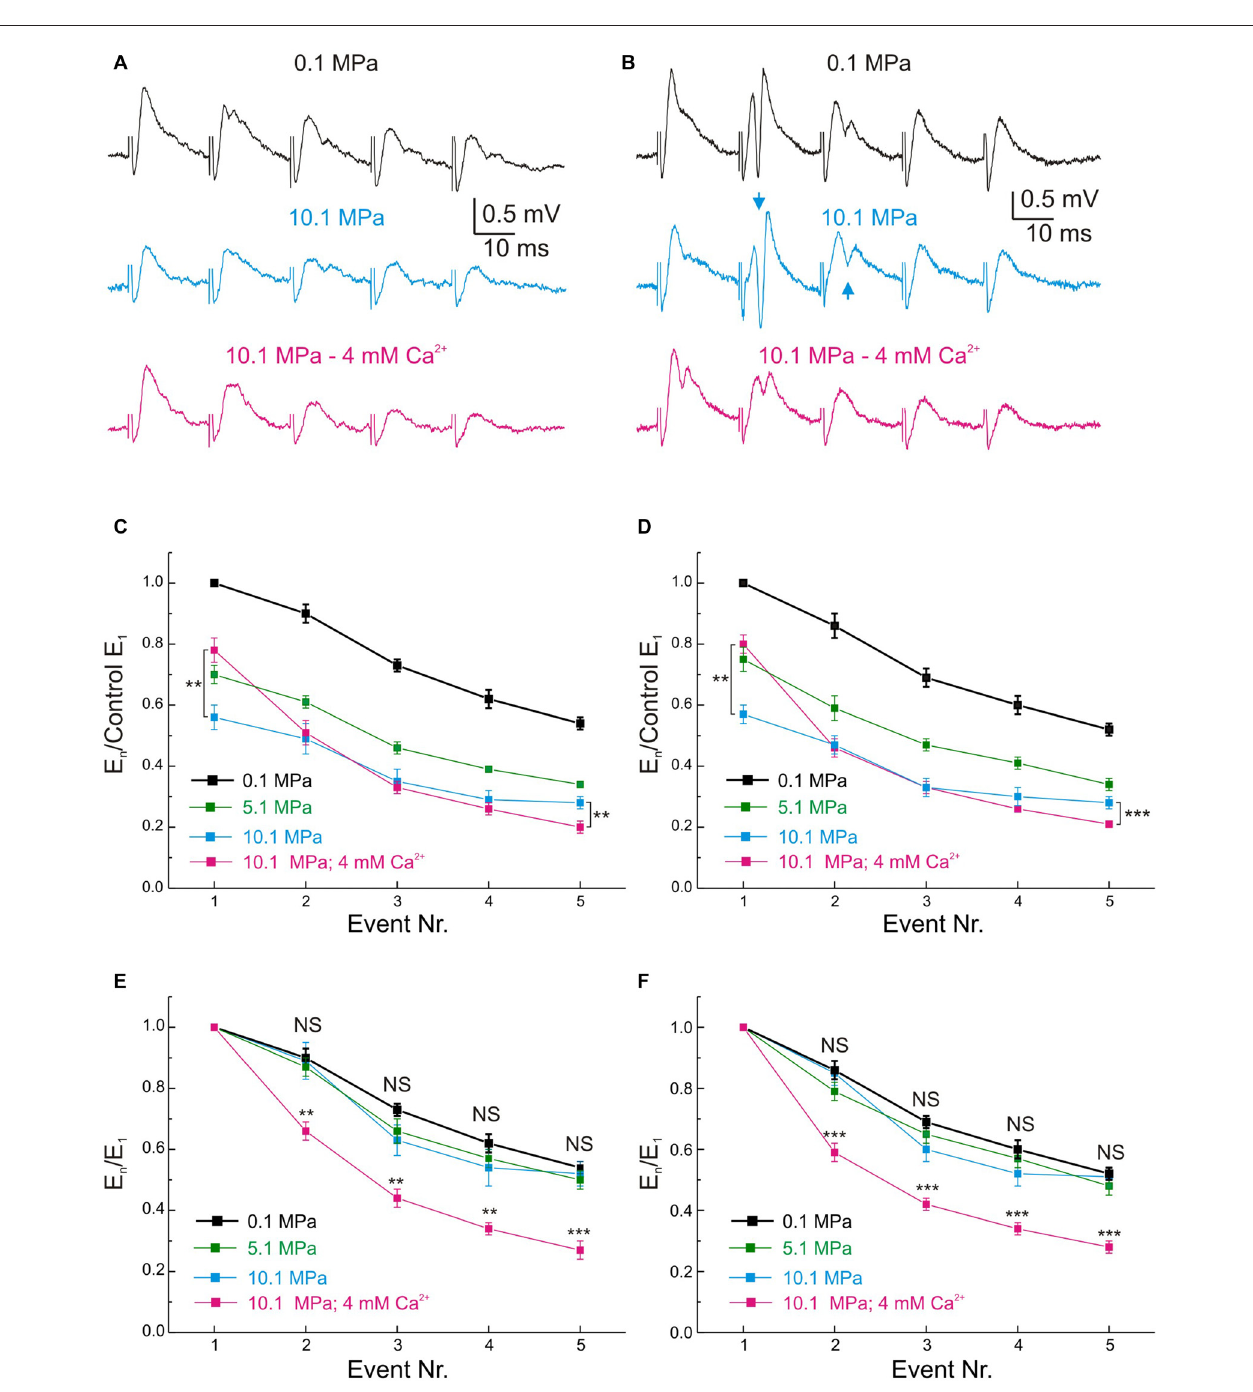
FIGURE 5 | Effects of pressure and [Ca 2 + ] o on the MPP fEPSP during stimulation at 50 Hz frequency. (A,B) Somatic field recordings at the GC layer of the DG showing the performance of fEPSPs under 0.1, 10.1 MPa 2 mM [Ca 2 + ] o and 10.1 MPa 4 mM [Ca 2 + ] o conditions. (A) Effects on subthreshold fEPSPs. (B) Effects on saturated suprathreshold fEPSP. Arrows mark the increase of PS strength at high pressure. (C) Time course of unsaturated fEPSPs’ slopes at 50 Hz under 0.1, 10.1 MPa 2 mM [Ca 2 + ] o and 10.1 MPa 4 mM [Ca 2 + ] o conditions (normalized to normobaric E 1 ; n = 21). (D) Course of saturated fEPSPs’ slopes at 50 Hz under 0.1, 10.1 MPa 2 mM [Ca 2 + ] o and 10.1 MPa 4 mM [Ca 2 + ] o conditions (normalized to normobaric E 1 ; n = 25). Note that for both fEPSPs’ saturation conditions E 5 at 4 mM [Ca 2 + ] o is significantly weaker than E 5 at 2 mM [Ca 2 + ] o . (E) Unsaturated fEPSPs’ slopes at 50 Hz under 0.1, 10.1 MPa 2 mM [Ca 2 + ] o and 10.1 MPa 4 mM [Ca 2 + ] o conditions (normalized to E 1 at each corresponding condition; n = 21). (F) Saturated fEPSPs’ slopes during stimulation at 50 Hz under 0.1 and 10.1 MPa—2 mM [Ca 2 + ] o and 10.1 MPa—4 mM [Ca 2 + ] o conditions (normalized to E 1 at each corresponding condition; n = 25). Notice that in unsaturated and saturated fEPSP responses, high pressure roughly preserves the frequency response of the input at control while high [Ca 2 + ] o enhances E 1 but filters E 2 –E 5 ( ∗∗ p < 0.01, ∗∗∗ p < 0.001).